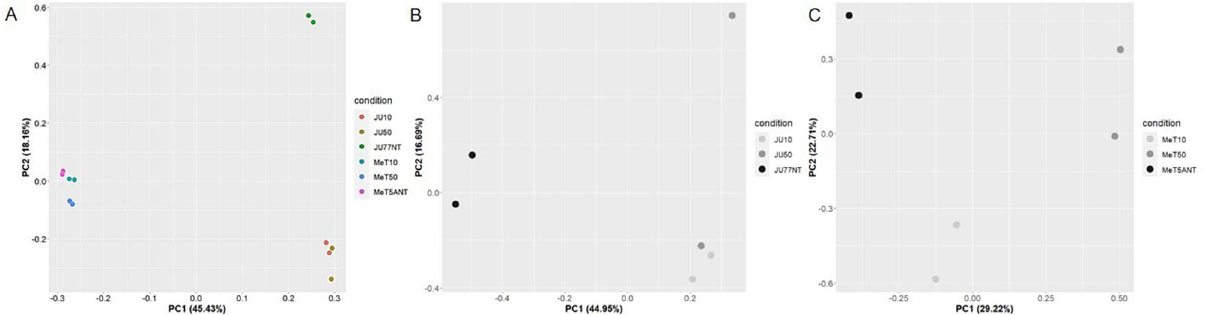
Figure 2. Principal Component Analysis (PCA) showing a separation in miRNAs and tRNA-derived ncRNAs between: ( A ) JU77 (human malignant mesothelioma) vs. MeT-5A (human normal mesothelium) cell lines; ( B ) JU77 controls vs. exposed to 10 and 50 ug/ml FE fibers; ( C ) MeT-5A controls vs. exposed to 10 and 50 ug/ml FE fibers.